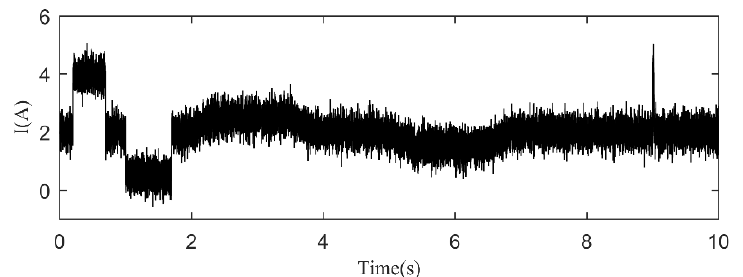
Figure 10. Photovoltaic signal simulation diagram under the noise of SNR 10.